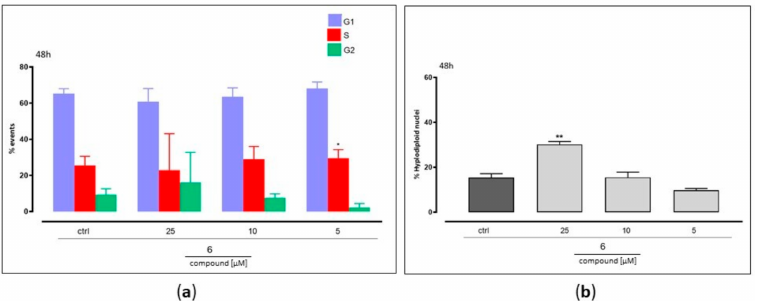
Figure 4. Cell cycle analysis: ( a ) DNA content and ( b ) hypodiploid nuclei, with propidium iodide staining, were evaluated by flow cytometric assay. HeLa cells were treated with 6 (5-10-25 µ M) for 48 h. Results are expressed as mean ± S.E.M. of three independent experiments each performed in duplicate. Data were analyzed by Student’s t -test. * p < 0.05 and ** p < 0.005 vs. non-treated.